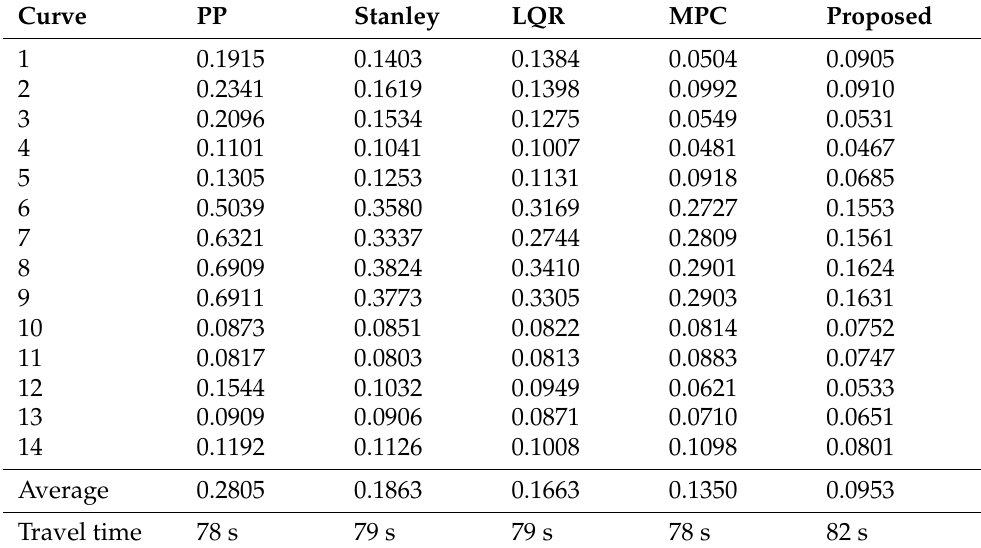
Figure 16. Steering angle of the autonomous vehicle. Table 3. Root mean square errors comparison in sharp curves of the proposed trajectory dataset. Results are presented in